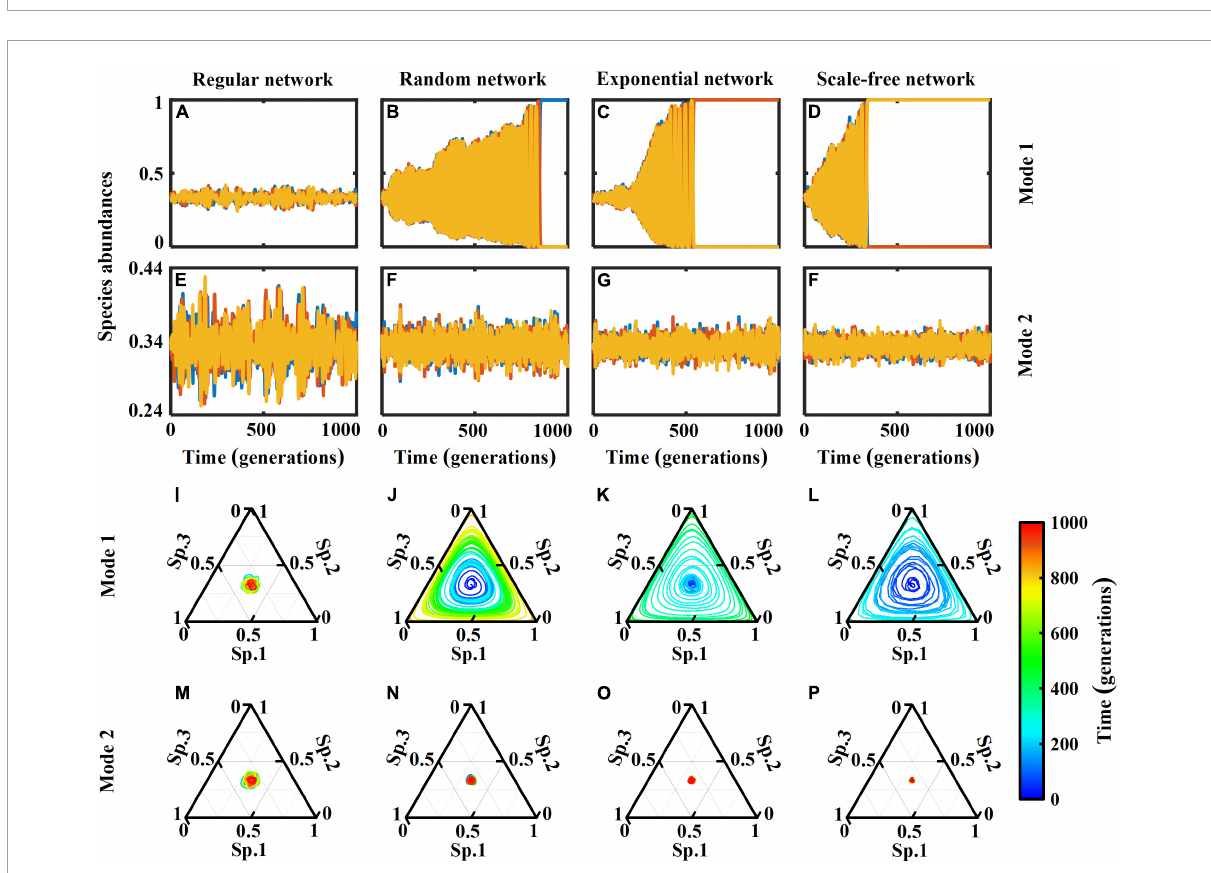
FIGURE2 (A–H) Dynamics of species abundances of a rock-paper-scissors system (with 1,000 generations = 1 × 10 7 time steps) in complex networks of size N = 10 4 nodes with 2 × 10 4 links (average patch degree k 4), including lattice-structured regular, randomly connected, exponential and scale-free networks. Two interaction modes are considered: (Mode 1) species compete to fill empty patches; and (Mode 2) species seize each other’s patches. (I–P) Trajectories in the phase space represented by the 3-simplex, corresponding to the dynamics in panels (A–H) . The color bar represents time evolution (generations). Oscillations around the equilibrium point cover a smaller area, indicating a more stable